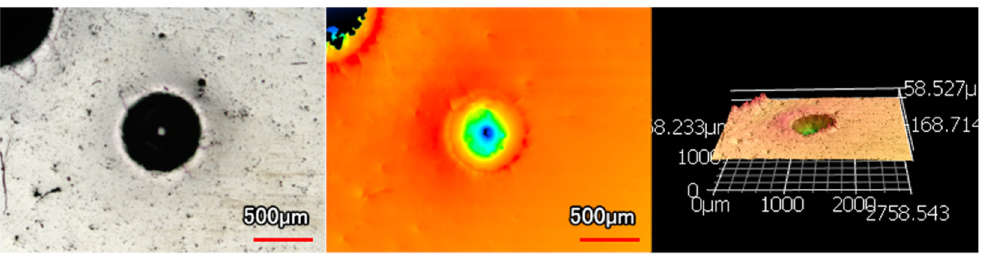
Figure 6. Rockwell Indentation on Ni-P-NiTi Coating.